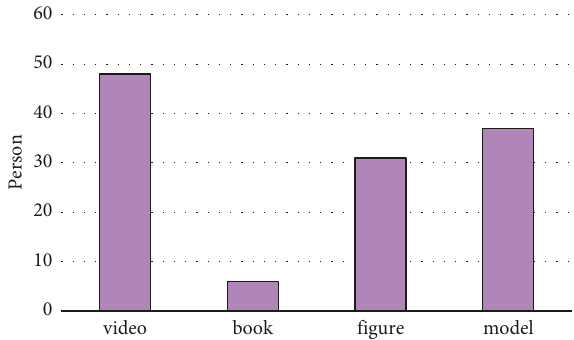
Figure 3: Percentage preferences for different educational